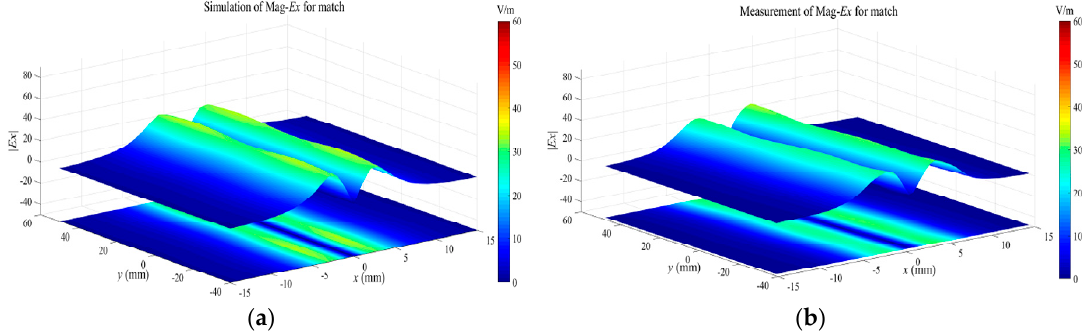
Figure 21 . ( a ) The simulated and ( b ) measured Ex-field distributions at the height of 2 mm over the